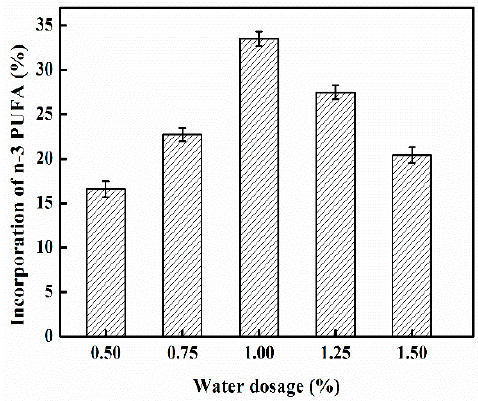
Figure 4. Effects of water dosage on the incorporation of n-3 PUFA. Reaction conditions were as follows: n-3 PUFA-rich EE/PC mass ratio of 6:1, enzyme loading of 20% ( w / w ), reaction temperature of 55 °C, and reaction time of 24 h under N 2 .